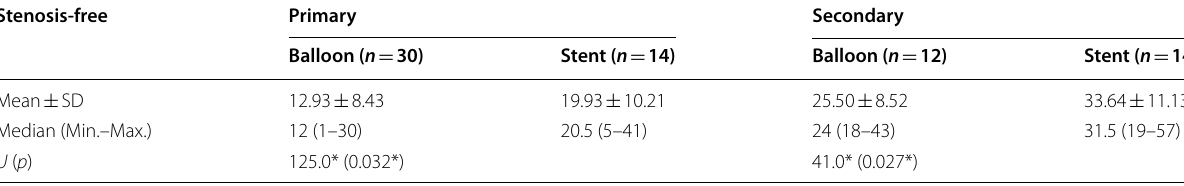
Table 3 Comparison between balloon and stent according to stenosis-free rate